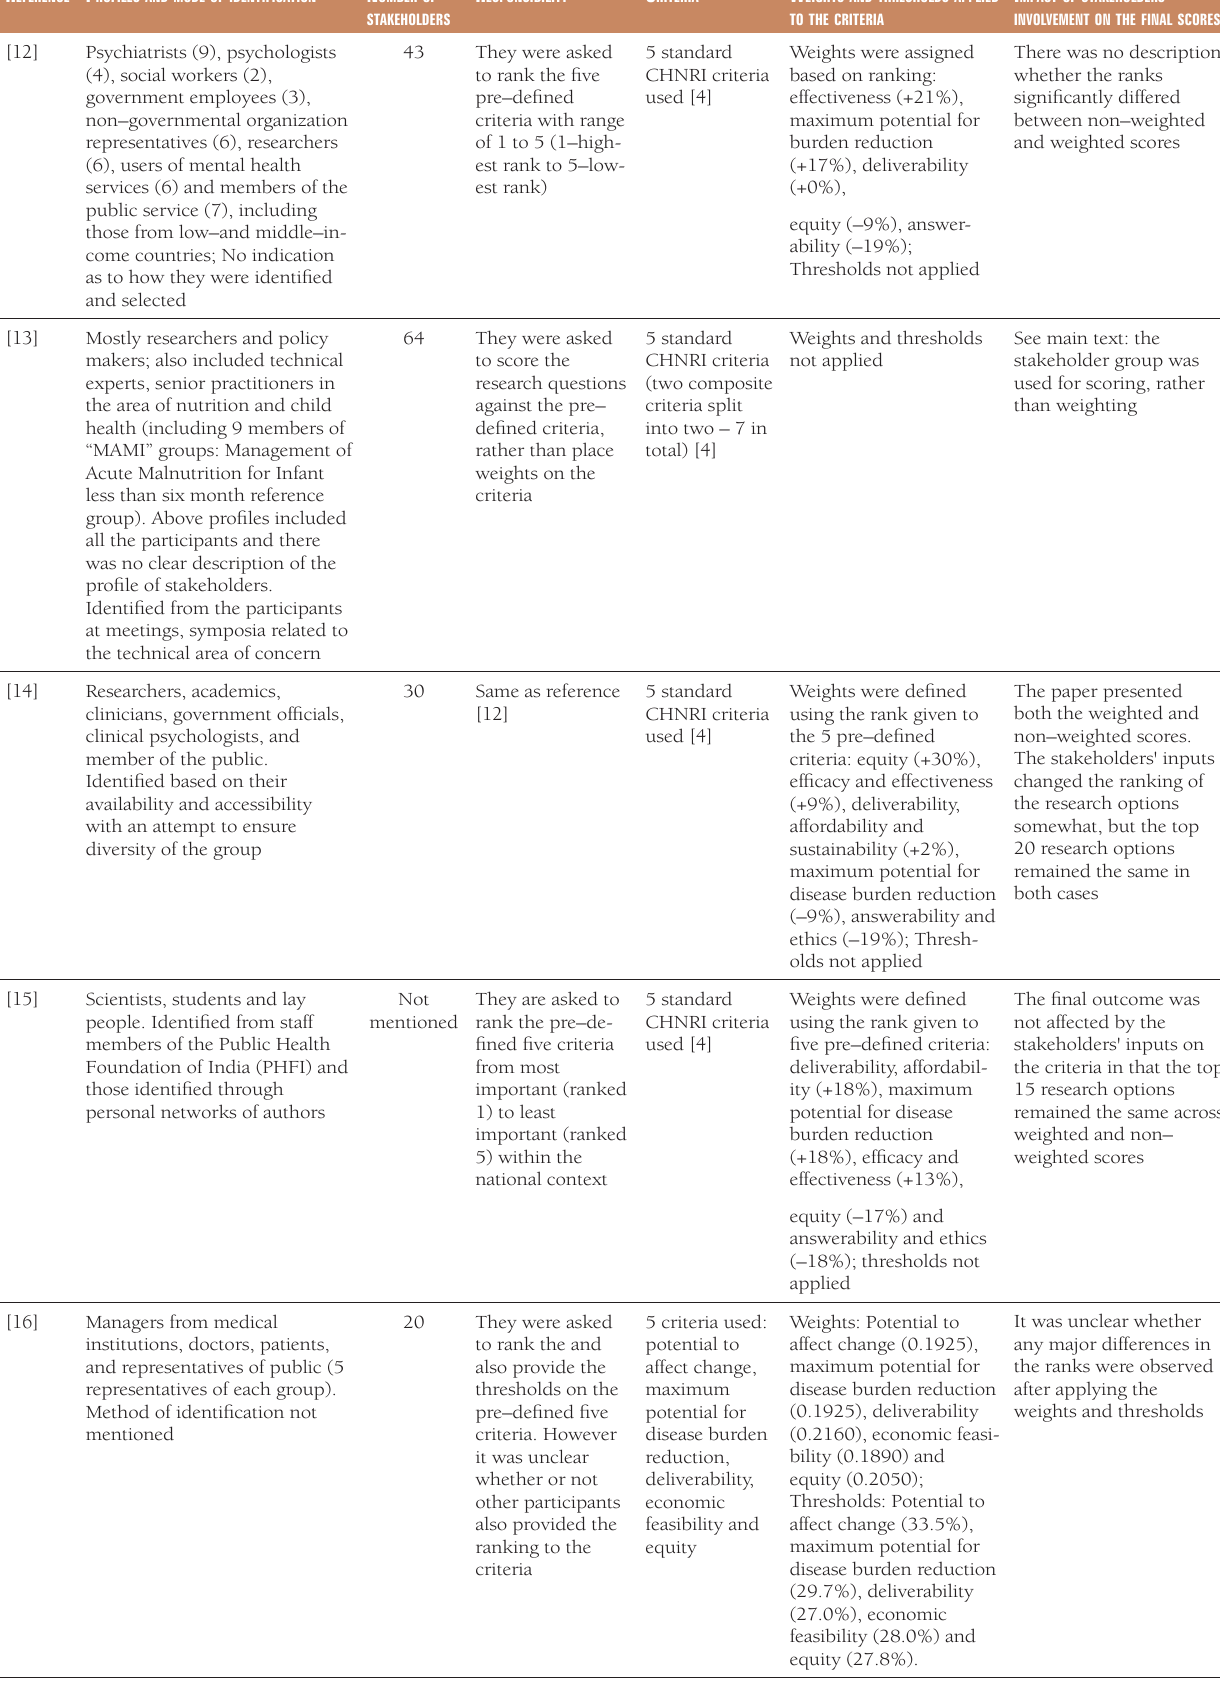
Table 1. Summary tables on the involvement of